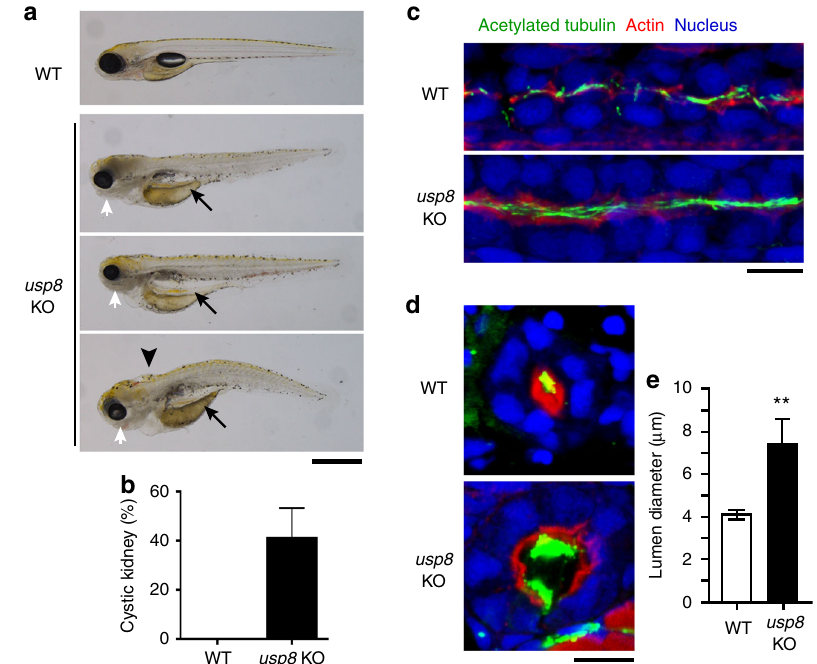
Fig. 3 usp8 knockout zebra fi sh displays ciliopathy-related phenotypes. a Wild-type (WT) and usp8 -knockout ( usp8 -KO) zebra fi sh with cystic kidney (arrows), hydrocephalus (arrowhead), and microphthalmia (white arrows) at 5 dpf. Scale bar, 500 μ m. b Incidence of cystic kidney in WT ( n = 75) and usp8 KO ( n = 101) at 4 or 5 dpf. c – e Immuno fl uorescence analysis of cilia of pronephric duct of WT and usp8 -KO at 27 hpf ( c , sagittal plane) and at 4 dpf ( d , transverse plane). Green, acetylated-tubulin; red, actin; blue: nuclei. Scale bars, 10 μ m. Pronephric duct lumen diameter of WT ( n = 11) and usp8 KO ( n = 7) at 4 dpf are shown as mean ± SD in e . ** p < 0.01, two-tailed unpaired student ’ s t